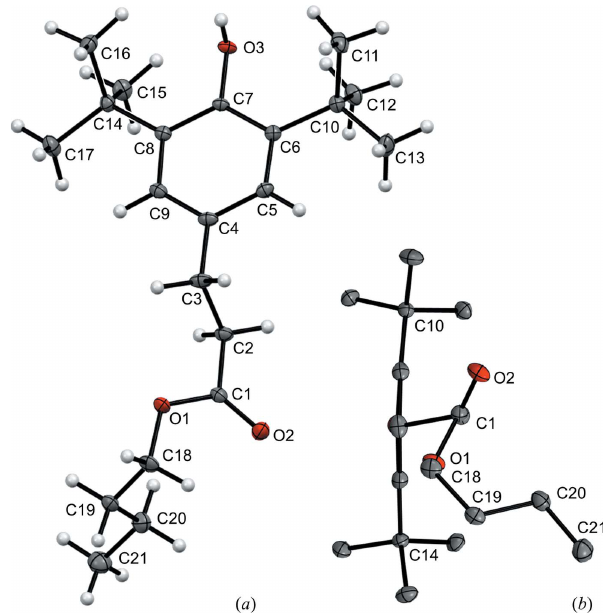
Figure 2 ( a ) The molecular structure of (I) at 100 K. Thermal displacement ellipsoids are shown at the 50% probability level. ( b ) Rotated view, H atoms excluded.